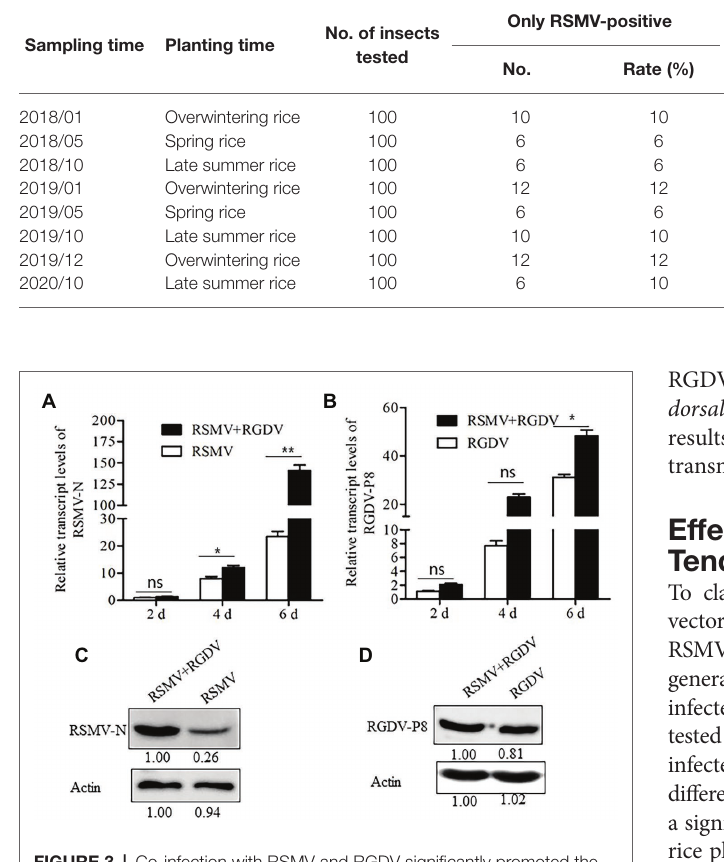
FIGURE 3 | Co-infection with RSMV and RGDV significantly promoted the infection of RSMV in the Recilia dorsalis vector. (A) The relative transcript levels of RSMV N in R. dorsalis infected with RSMV or co-infected with RGDV and RSMV were determined by RT-qPCR at 2, 4, and 6 days padp. (B) The relative transcript levels of RGDV P8 in R. dorsalis infected with RGDV or co-infected with RSMV and RGDV were determined by RT-qPCR at 2, 4, and 6 days padp. Means (±SD) from three biological replicates are presented. * p < .05; ** p < .01; and ns, not significant. (C) The accumulation levels of RSMV N in R. dorsalis infected with RSMV or co-infected with RGDV and RSMV for 6 days padp were detected by Western blot assay. Insect actin was detected as a control. (D) The accumulation of RGDV P8 in R. dorsalis infected with RGDV or co-infected with RSMV and RGDV for 6 days padp were detected by Western blot assay. Insect actin was detected as a